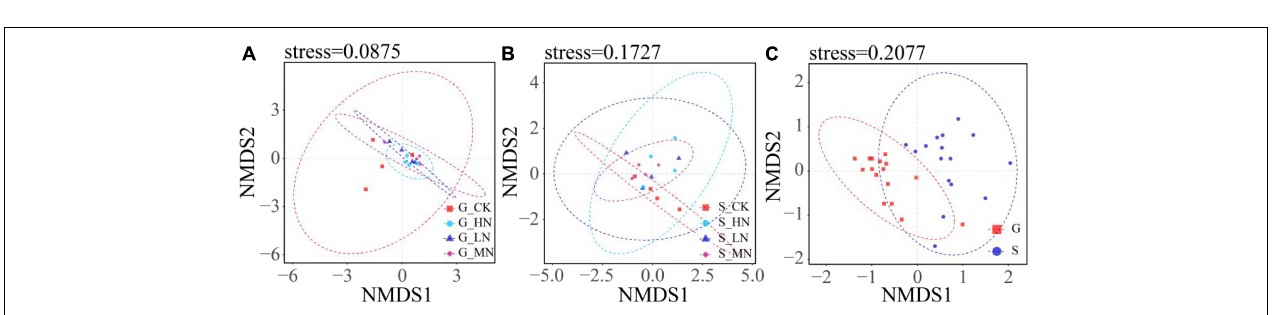
FIGURE 5 | Abundance and diversity index of carbon-fixing microbial community in soil samples. Different lowercase letters represent significant differences among treatments in the same slope, and different uppercase letters represent significant differences among slopes.